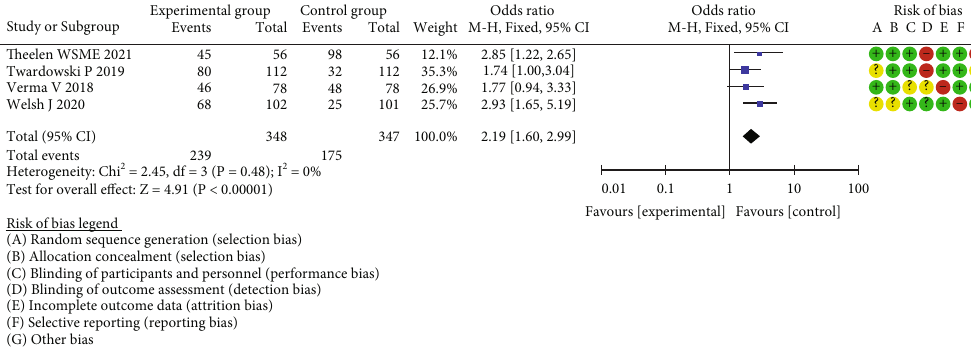
rhombus plot and vertical line did not intersect in the forest map of e ff ect of adverse e ff ects of adoptive immunotherapy for the included 4 studies, indicating the signi fi cant di ff er- ence in adverse e ff ects of adoptive immunotherapy between the experimental and control groups ( OR = 1 : 76 , 95% CI (1.25, 2.48), P = 0 : 001 , I 2 = 0 % , Z = 3 : 26 ) (Figure 5).